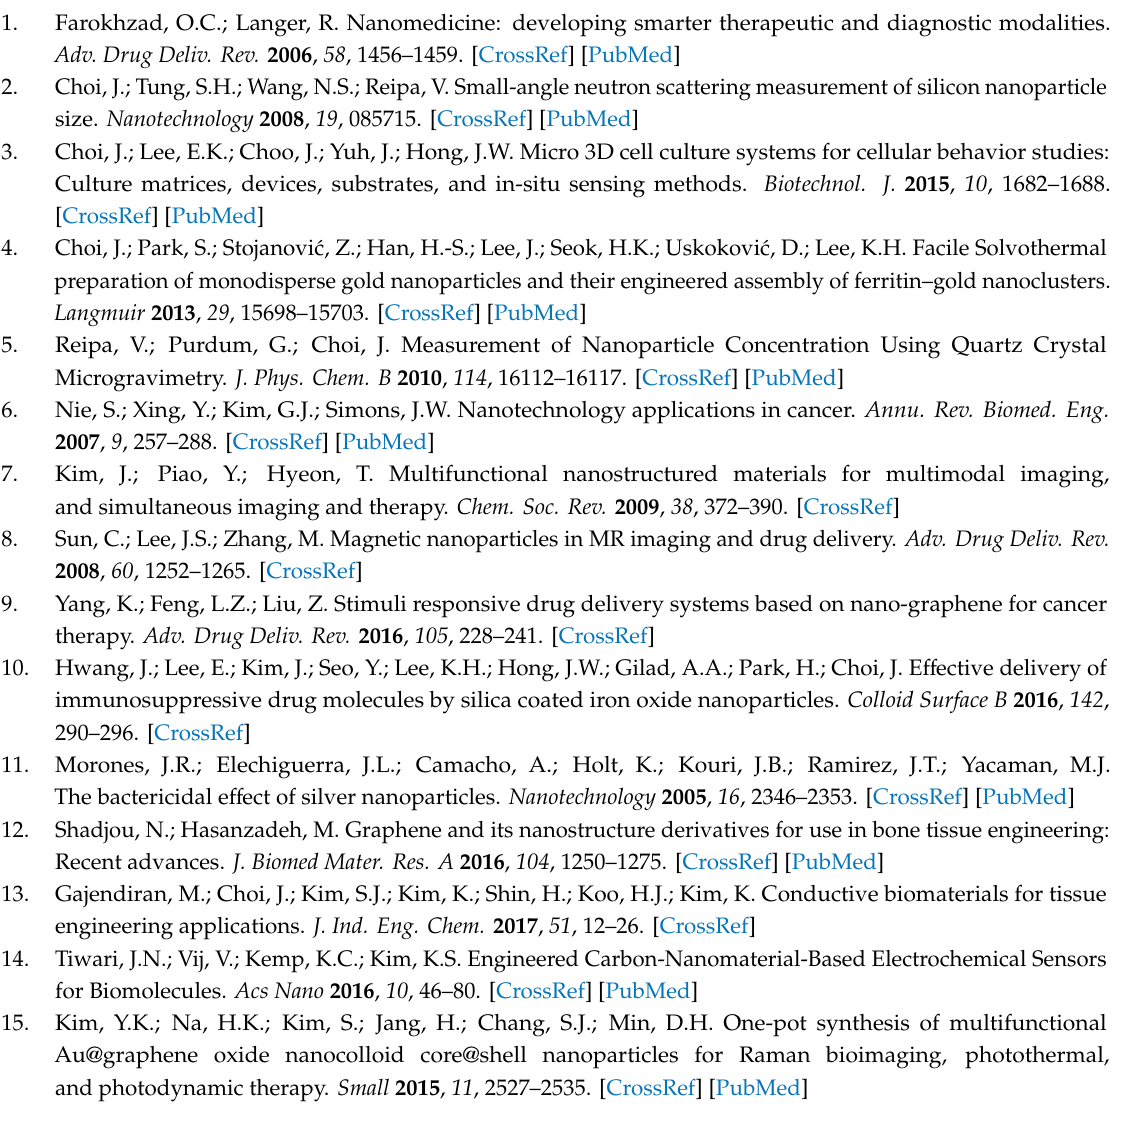
Figure S1. XPS spectra of C1s (A and C) and O1s (B and D) peaks of CNO (A and B) and CNO–COOH (C and D). Figure S2. Spectral survey of (A) CNO and (B) CNO–COOH, showing increased oxygen contents. Figure S3. (A) Fluorescent microscopic images from live and dead assay for CNO and CNO–COOH with di ff